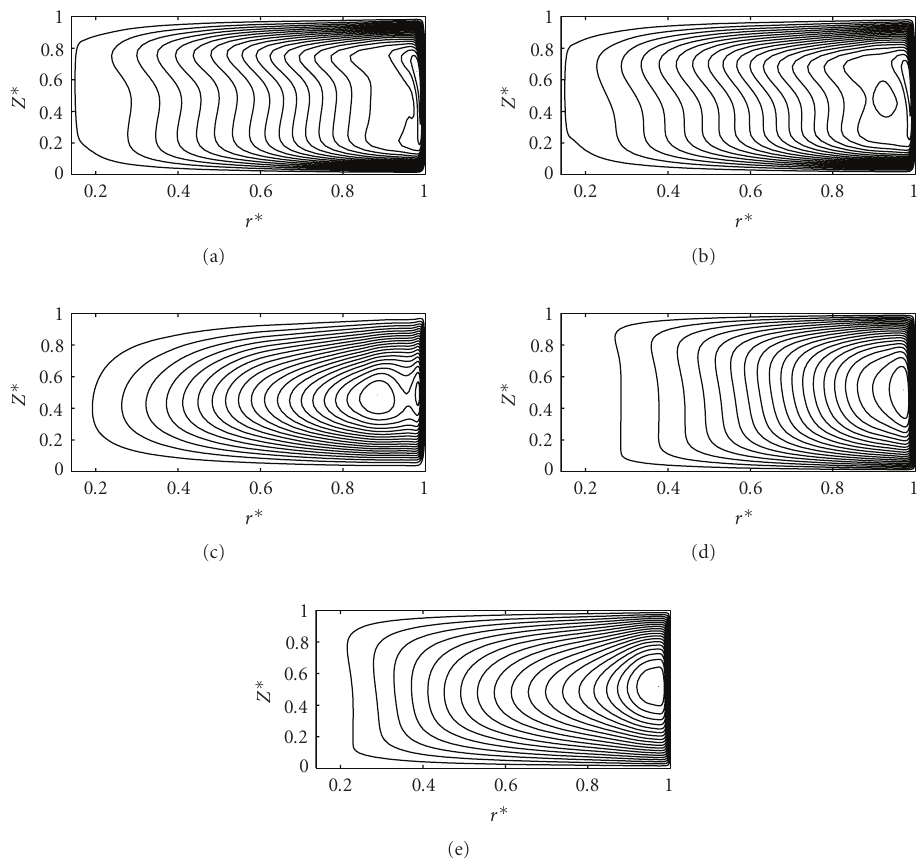
Figure 8: Influence of the aspect ratio on the streamline patterns Ψ ∗ = Ψ / ( Ω h 2 ) (20 contours) for various sets of flow parameters (Re, G ): (a) (1 . 8 × 10 5 , 0 . 05), − 0 . 03 ≤ Ψ ∗ ≤ 5 . 96; (b) (1 . 8 × 10 5 , 0.04), − 0 . 05 ≤ Ψ ∗ ≤ 10 . 8; (c) (1 . 8 × 10 5 , 0 . 02), − 0 . 31 ≤ Ψ ∗ ≤ 76 . 89; (d) (5 × 10 6 , 0 . 04), − 0 . 04 ≤ Ψ ∗ ≤ 8 . 32; (e) (5 × 10 6 , 0 . 02), − 0 . 32 ≤ Ψ ∗ ≤ 36 .